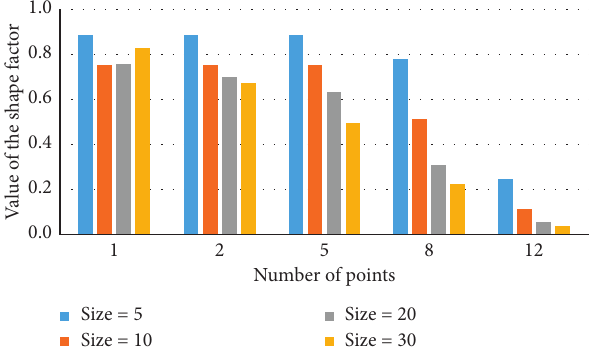
Figure 6: The relationship between the value of the shape factor and the size of the percolation window.